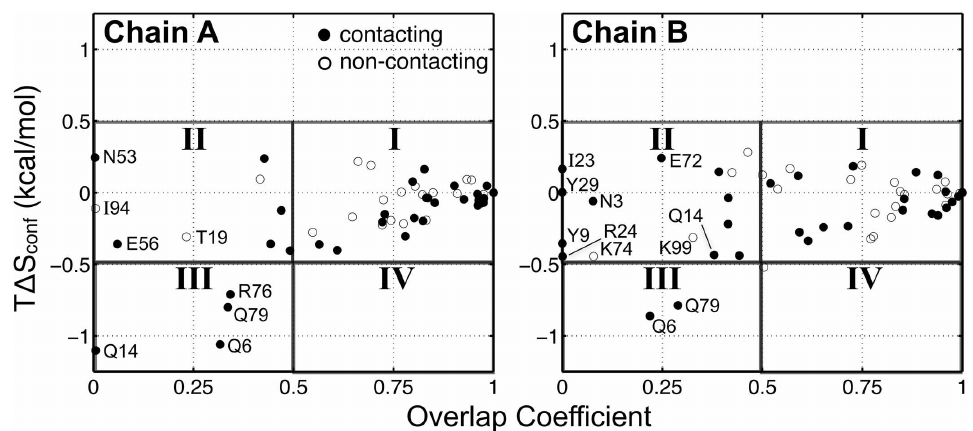
Fig 4. Comparison of changes in side-chain conformation ( OC ) and dynamics ( T Δ S conf ). Data is shown for all rotameric residues in CVN chains A (left) and B (right). The plots are dividedinto four quadrants,which reflect the effect of the crystal environment on conformation and dynamics: I) small or no effect on conformation and dynamics; II) changein conformation, small effect on dynamics; III) change in conformation and in dynamics; and IV) changein dynamics, small effect on conformation. Filled data points denote residues participating in a crystal contact, and open circles represent non-contacting